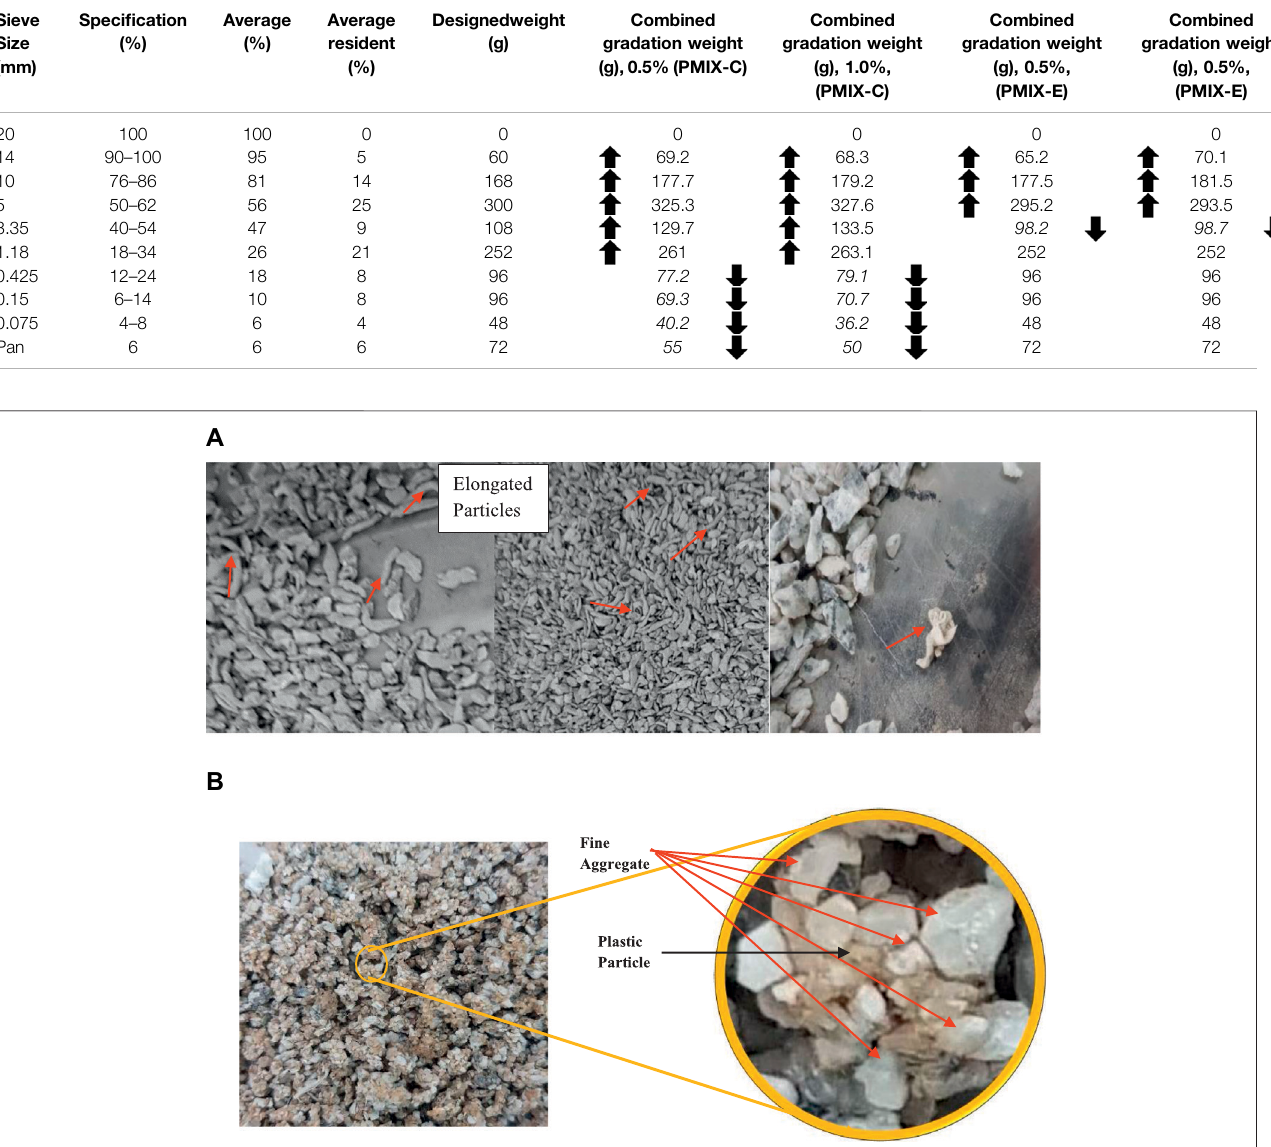
Frontiers in Materials |